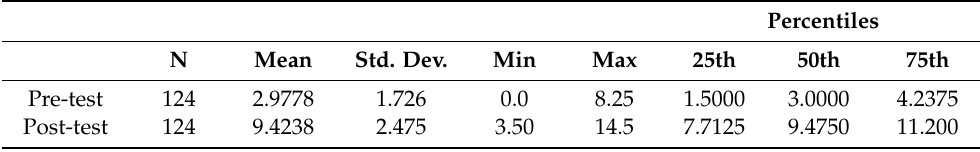
Table 6. Descriptive statistics of results of students.